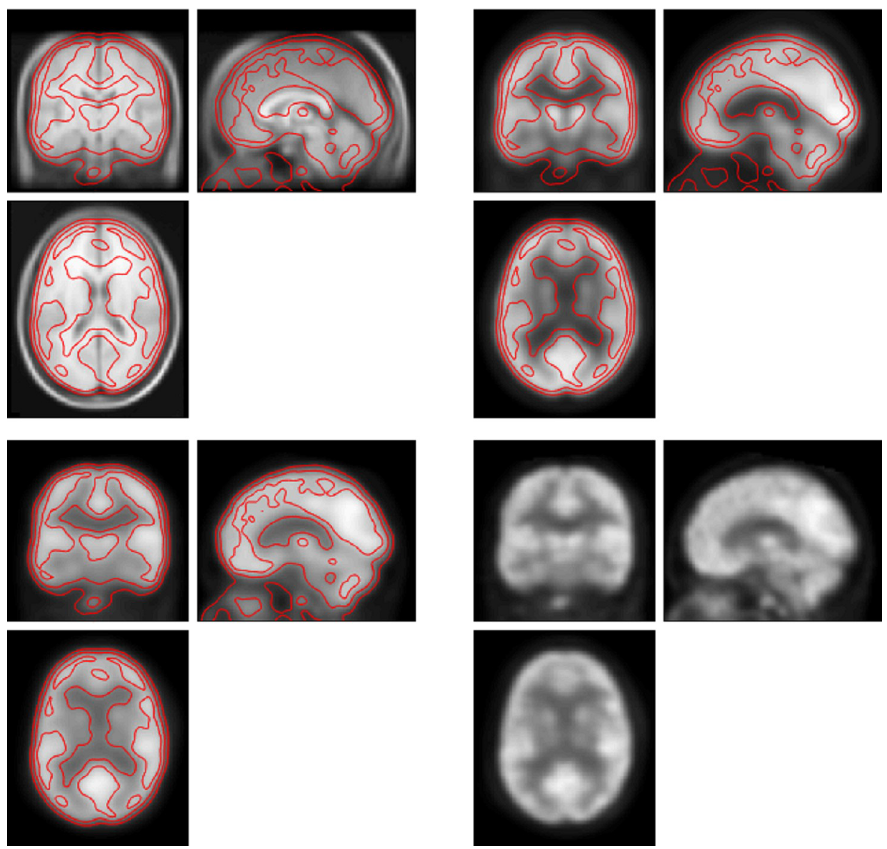
Fig 1. Example of FDG PET imaging post-processing. Left upper panel: MRI brain template (T1) with coronal, sagittal, and axial views, generated from 305 normal subjects. Right upper panel: FDG PET brain template of summed 100 normal subjects. Left lower panel:Smoothed FDG PET brain of one study subject. Right lower panel: Normalized FDG PET brain of the same subject. The red line is the contour of the subject’s normalized brain